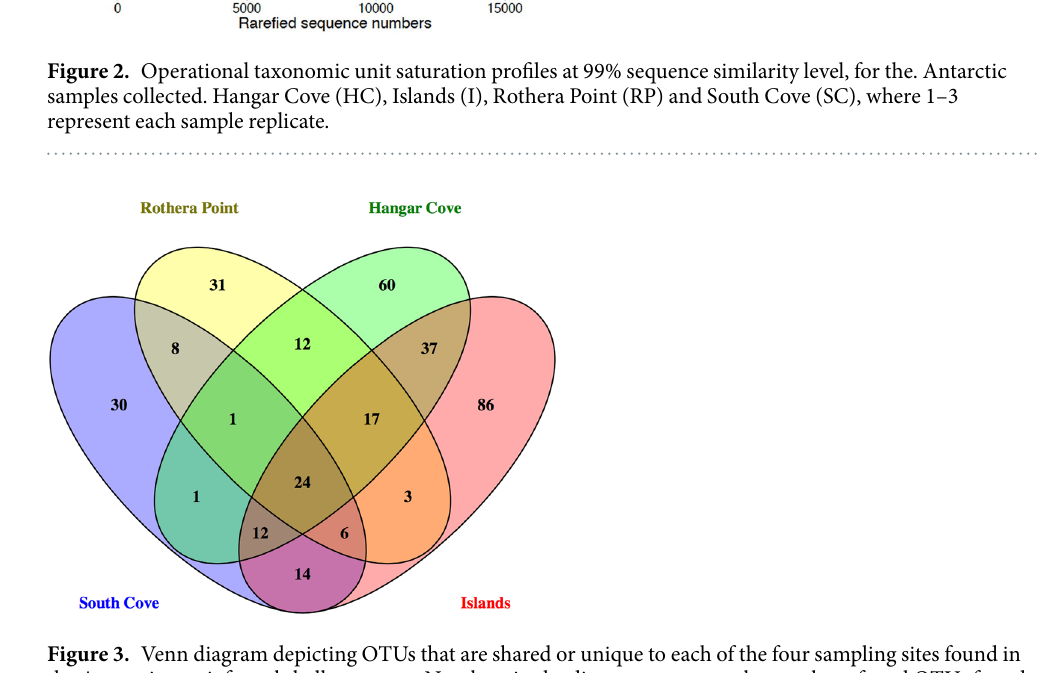
the subclass Palpata (31%) and infraclass Scolecida (54%). The Palpata comprised the Phylodocida order (23%) and taxa with uncertain taxonomic position (Incertae Sedis) (8%). The Scolecida covered five distinct families with the Spionida (15%), Orbibidae (15%), Terebellida (8%), Ophellidae (8%) and the Capitellida (8%) (Fig. 4b, Supplementary Table S1.1–S1.3, Supplementary Material S1), identifications which have been further substanti- ated by 18 s rRNA molecular barcoding of polychaete samples from shallow-water hard and soft sediment com- munities near Rothera (Clark, unpublished data). The shallow-water comparisons with deep-water samples taken from along the Antarctic Peninsula showed very different community compositions (Supplementary Figure S4). Although the annelids and nematodes were found at both depths, they were particularly dominant in the deep-water samples. Shallow-water samples had a much higher percentage of arthropods (or more precisely, copepods). The Nemertea and Hemicordata were essentially only found in the deep samples, with the Cnidaria, Echinodermata and Mollusca more common in the shallows. The difference in community composition was further substantiated by pairwise comparisons of the number of shared OTUs between the different deep-water samples with the combined shallow samples, with the shallow-water sites sharing on average ca. 15% of OTUs with the different deep-water sites (Supplementary